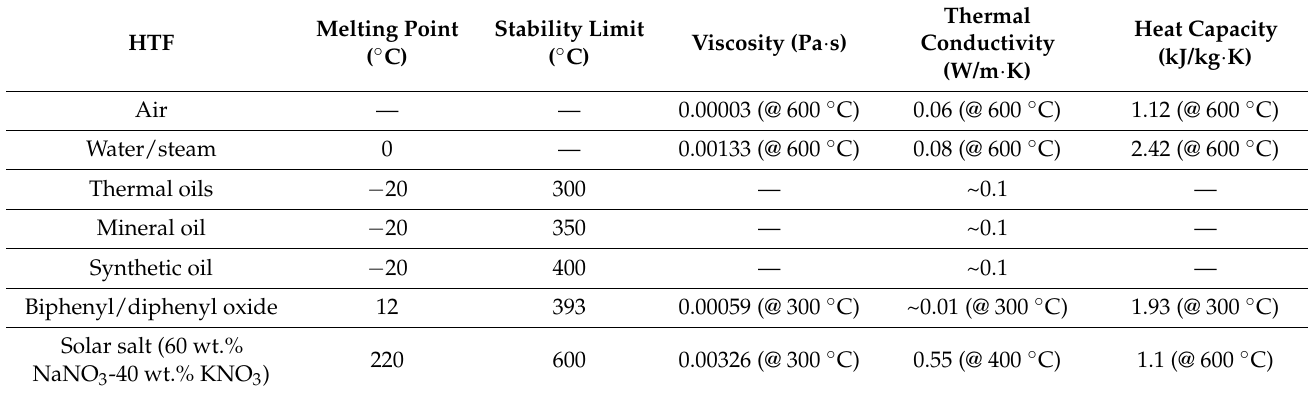
Table 2. Thermophysical properties of heat transfer fluids used in CSP plants